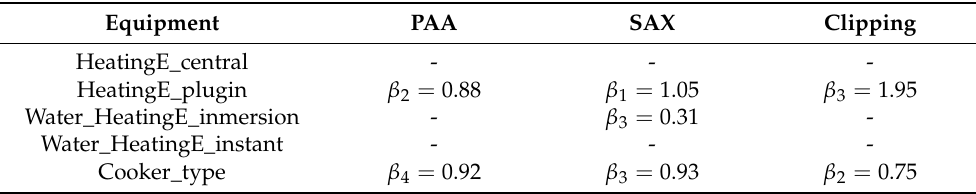
Table 2. Comparative results for equipment detection using logistic regression coefficients.